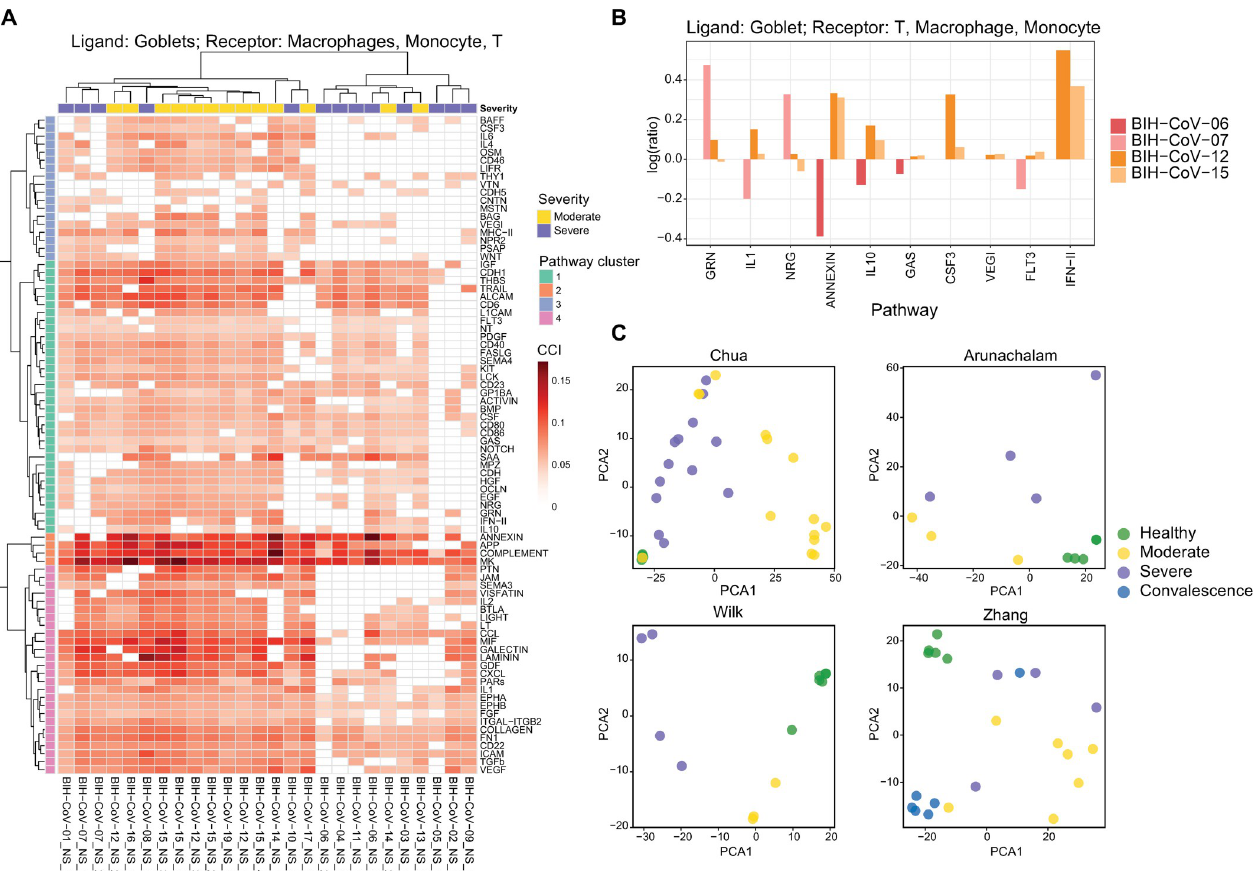
Fig 4. Goblet and immune cell interaction in COVID-19 patients. A. Heatmap of the pathway-specific cell-cell interaction contribution in goblets as ligands and immune cells (macrophages, monocytes and T cells) as receptors in the Chua dataset, where the rows indicate the signaling pathways and columns indicate the samples. The signaling pathways are clustered into 6 groups. B. Bar plot indicates the log-ratio of cell-cell interaction contributions between two time points (y-axis) for longitude samples of 4 patients (2 moderate: BIH-CoV-12, BIH-CoV-15; 2 severe: BIH-CoV-06, BIH-CoV-07) in goblets as ligands and immune cells (macrophages, monocytes and T cells) as receptors. The x-axis represents the signaling pathways. C. PCA for samples using the selected pathway-specific cell-cell interaction features, colored by disease severity (Healthy, Moderate, Severe, Convalescence): the Chua dataset (top left panel), the Wilk dataset (bottom left panel), the Arunachalam dataset (top right panel) and the Zhang dataset (bottom right panel) with the corresponding LOOCV accuracy rate for four datasets presented in S1 Table.